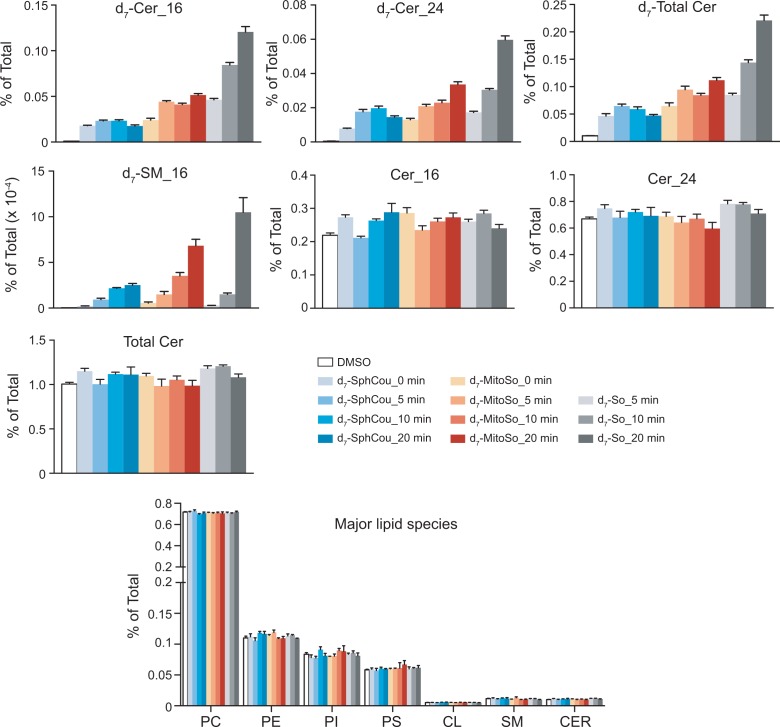
Total lipid profiles after releasing sphingosine in different subcellular compartments.Values were normalized with respect to the amount of internal standards and were plotted as percentage of all lipid signals. Data represent the average of three independent experiments. Error bars represent SEM.